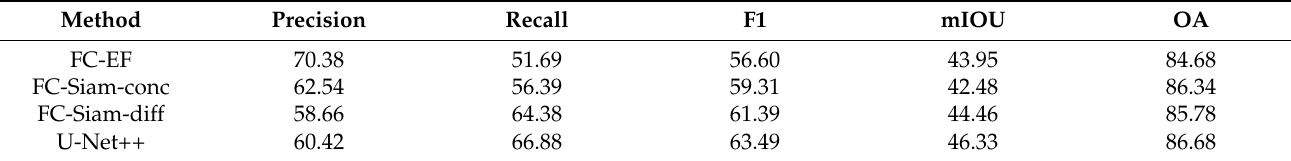
Table 9. Comparison of results on DSIFN dataset. The bold numbers indicate the best